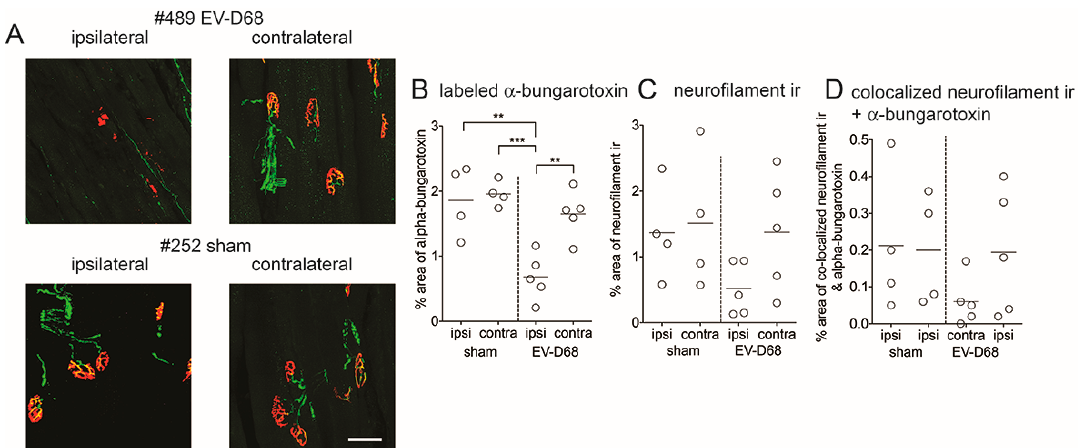
Figure 9. Reduced neuromuscular junction (NMJ) innervation in gastrocnemius muscles of AG129 mice infected with EV-D68 six weeks after paralysis onset. ( A ) neurofilament (NF) ir (green), fluorescence-tagged α -btx (red) in sham- and EV-D68-infected mice. Scale bar = 50 µm; ( B ) Quantification of labeled α -btx to detect motor plates; ( C ) Quantification of neurofilament ir to detect axons; ( D ) Quantification of co-localization of neurofilament ir and labeled α -btx to detect innervated NMJ (yellow). Vertical dotted lines separate sham and infected data. ** p < 0.01, *** p < 0.001 using t -test.